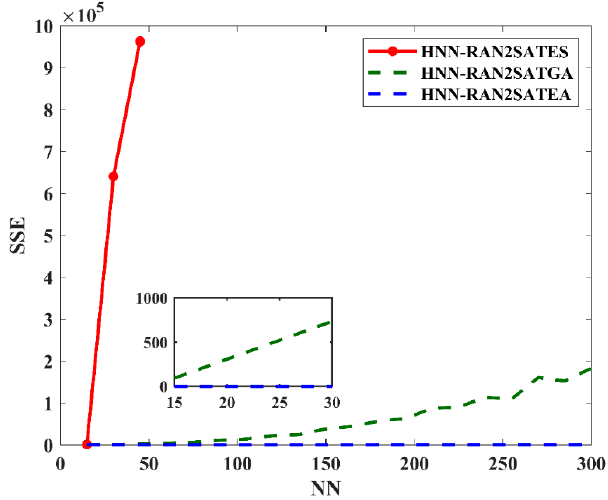
Figure 4. Sum of squared error (SSE) evaluation of various HNN-RAN2SAT models.